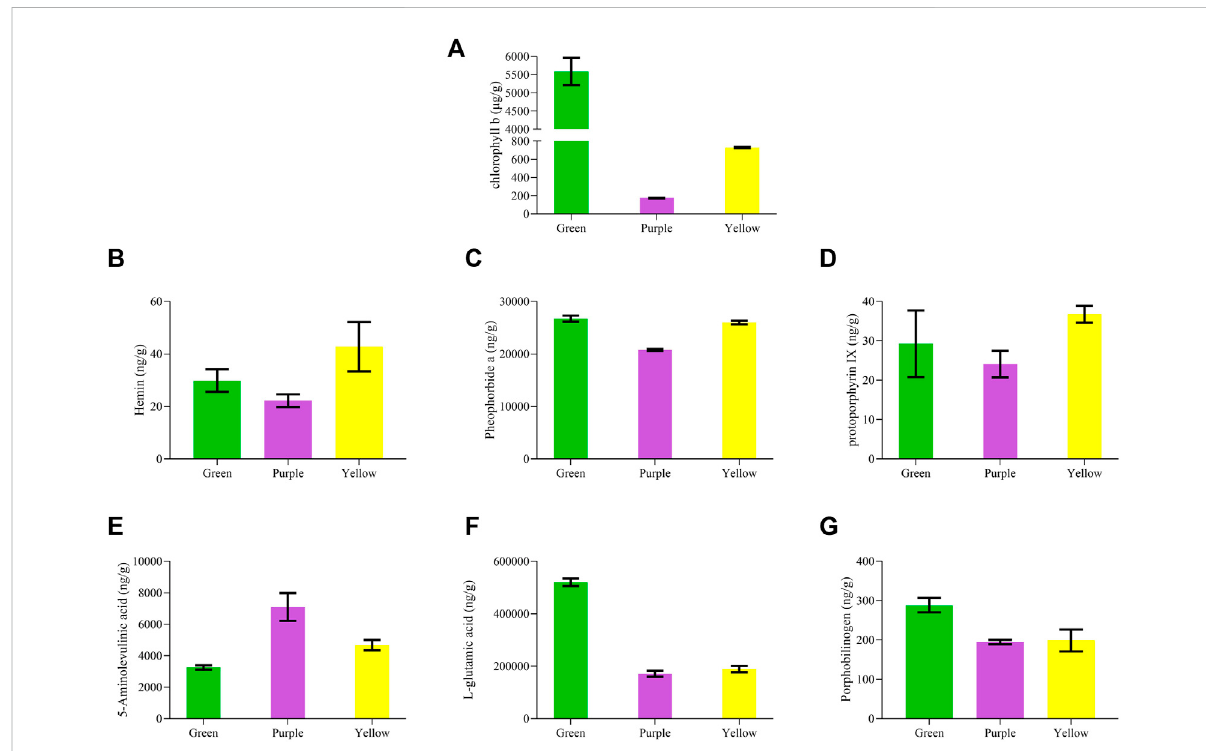
FIGURE 2 Chlorophyll pro fi ling of purple, yellow, and green leaves in C. ensifolium . (A) chlorophyll b, (B) hemin, (C) pheophorbide, (D) protoporphyrin IX, (E) 5-aminolevulinic acid, (F) L-glutamic acid, and (G)